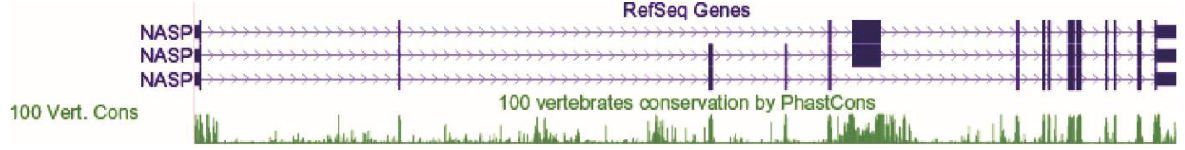
Figure 2. The intron-exon structure of a typical human gene displayed on the UCSC genome browser [6]. Introns are shown as lines (the “arrowheads” in the lines indicate the direction of transcription). Exons are shown as vertical bars. Coding exons are shown as thicker vertical bars than non-coding exon sequence. This example shows the NASP gene. The gene structures shown are “ Refseq genes ” that represent known human protein-coding and non-protein-coding genes taken from the NCBI RNA reference sequences collection. Notice that this single gene locus contains three distinct Refseq annotations containing different exon structures. Conserved sequences detected by comparative genomic information from 100 vertebrate genome sequences are shown at the bottom as a Phastcons plot — the higher values are most conserved, and often correspond to